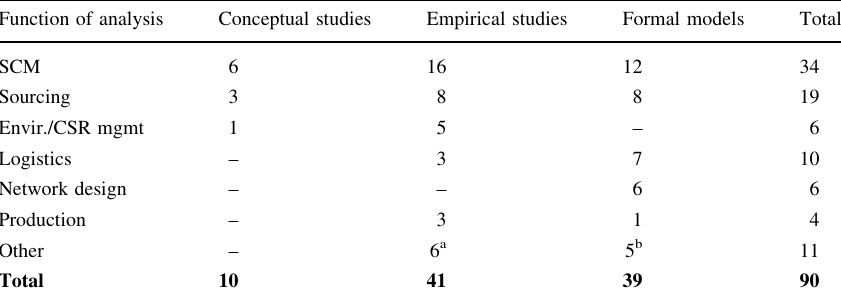
Function of analysis Conceptual studies Empirical